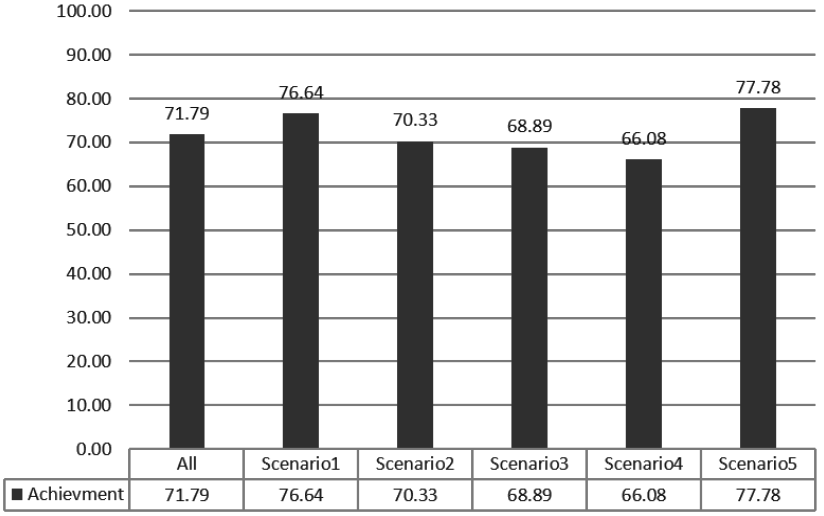
Figure 14. The results of emotion achievement for the five scenarios. The achievement depends on how similar the induced emotion is to the target emotion.